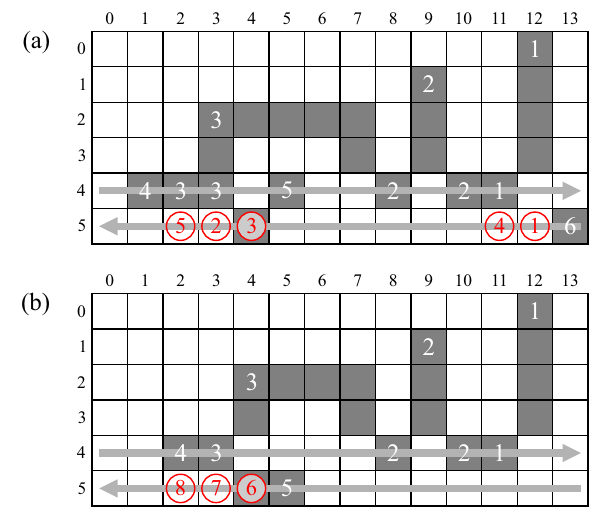
Figure 14. Accesses to update the merger table: ( a ) Scenarios with no conflicts; ( b ) Scenarios with